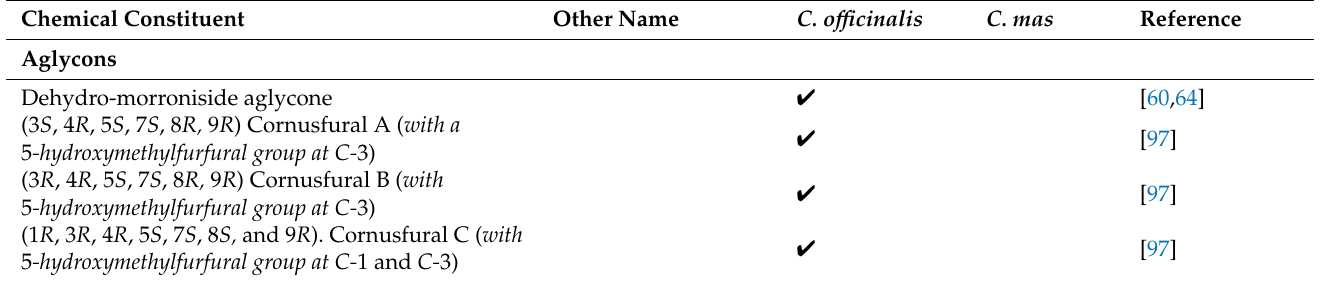
Table 6. The main iridoids of Cornus